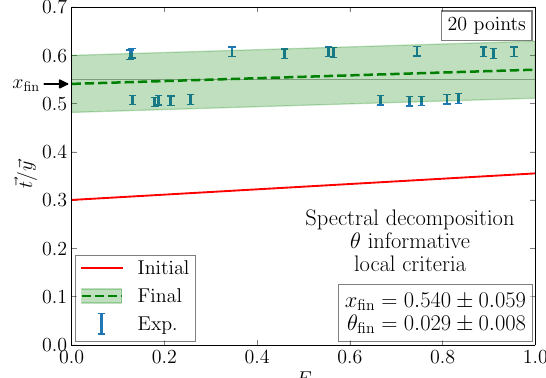
Figure 7. Uncertainty propagation in the spectral method with a local criteria